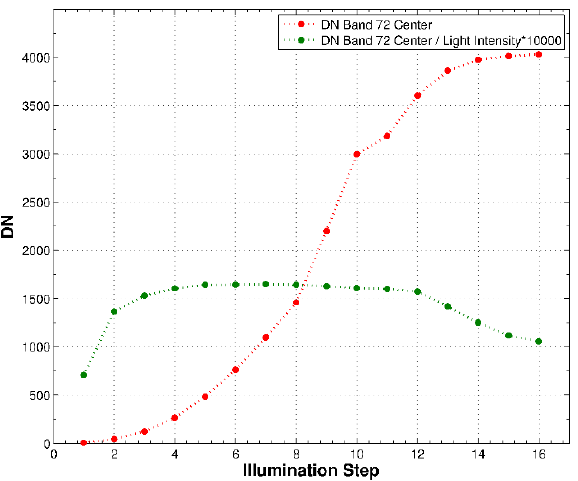
Figure 4: Measured DN (red) and ratio between DN and light intensity of the sphere (green). For a better visualization the latter value was multiplied by